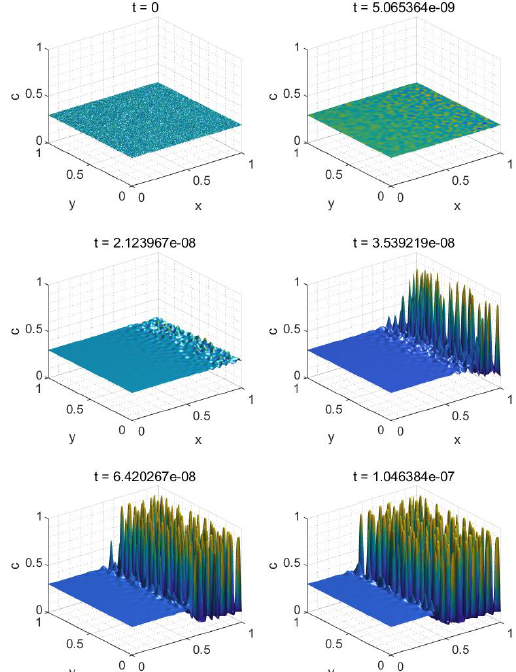
Figure 2. Dimensionless concentration spatial profiles c * ( x * , y * ) formed during the phase separation phenomena for the case where D = 10 5 , c o* = 0.3 and T 1* = 0.34 at x * = 0 and T 2* = 0.30 at x * = 1. The asterisks were left out of the variables x , y , c , and t in the figure.